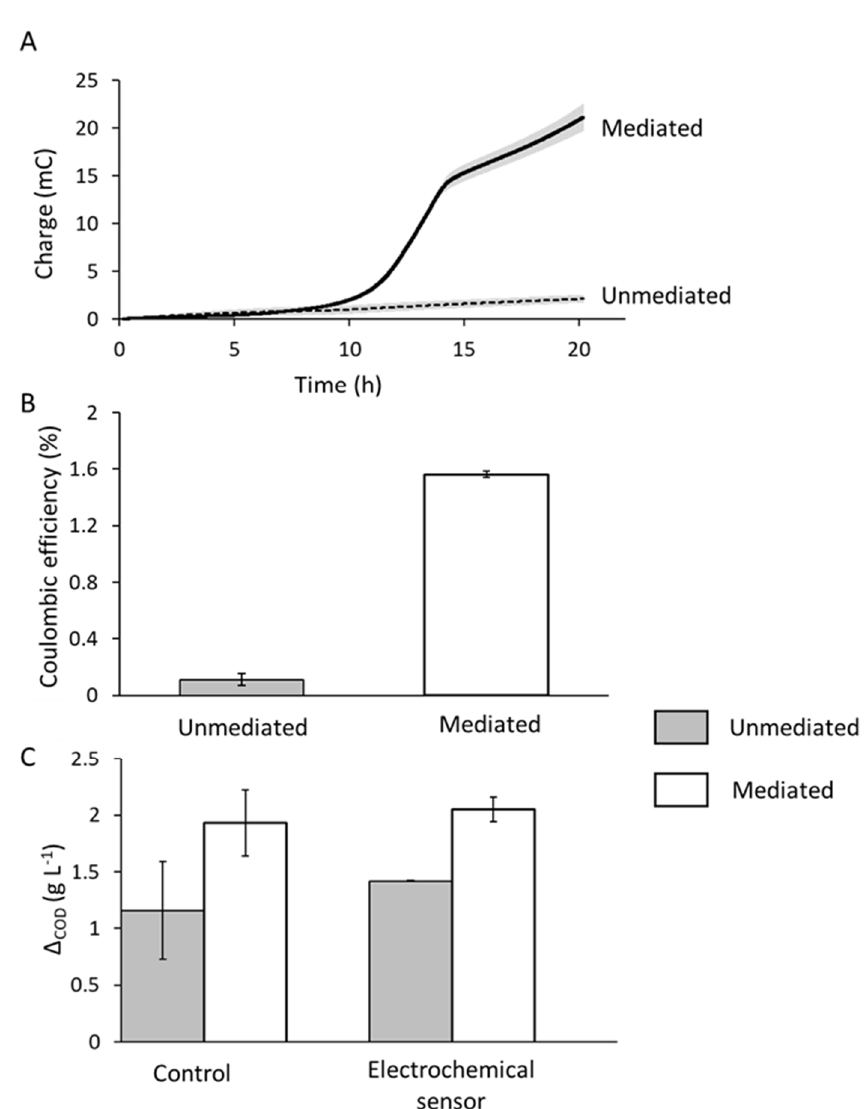
Figure 4. ( A ) Mean charge and ( B ) mean coulombic efficiency of E. faecalis in systems grown in electrochemical conditions. ( C ) Comparison of COD consumption by E. faecalis in benchtop incubations and electrochemical conditions. The shaded area in ( A ) and the error bars in ( B , C ) represent the absolute error of duplicate measurements.